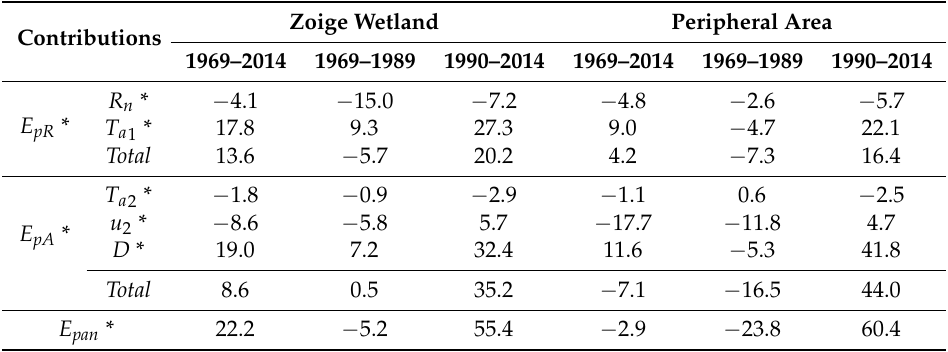
Figure 5. Dominant factors controlling pan evaporation change in the Zoige wetland and its peripheral areas, ( a ) 1969–2014, ( b ) 1969–1989, and ( c ) 1990–2014. The numbers in brackets denote the frequency that each factor is the most important governing E pan trend, and the numbers behand each symbol refer to the contribution rate (unit: mm decade − 1 ) of climate factors. Table 5. Contributions of climate factors to changes in annual pan evaporation for the Zoige wetland and its peripheral area as a whole, respectively (unit: mm decade − 1 ).